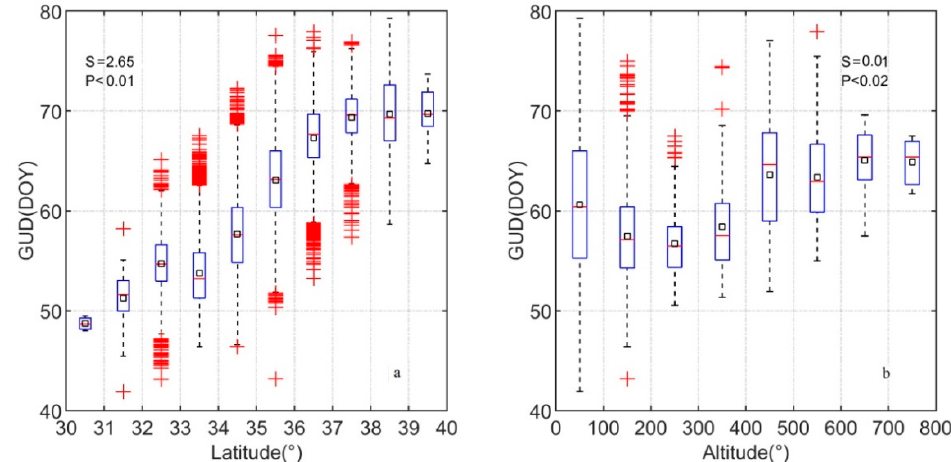
Figure 5. The latitudinal ( a ) and elevational ( b ) shifts in multiyear averaged GUD. The bottom and top edges of each blue box indicate the 25th and 75th percentiles, respectively. The horizontal red line in each blue box represents the median values. The black square in each blue box represents the mean values. The black whiskers extend to the 1.5 times the interquartile range. Red crosses mean outliers. The black texts in the upper corner present the slope (S) and significance (P) of the corresponding linear regression.